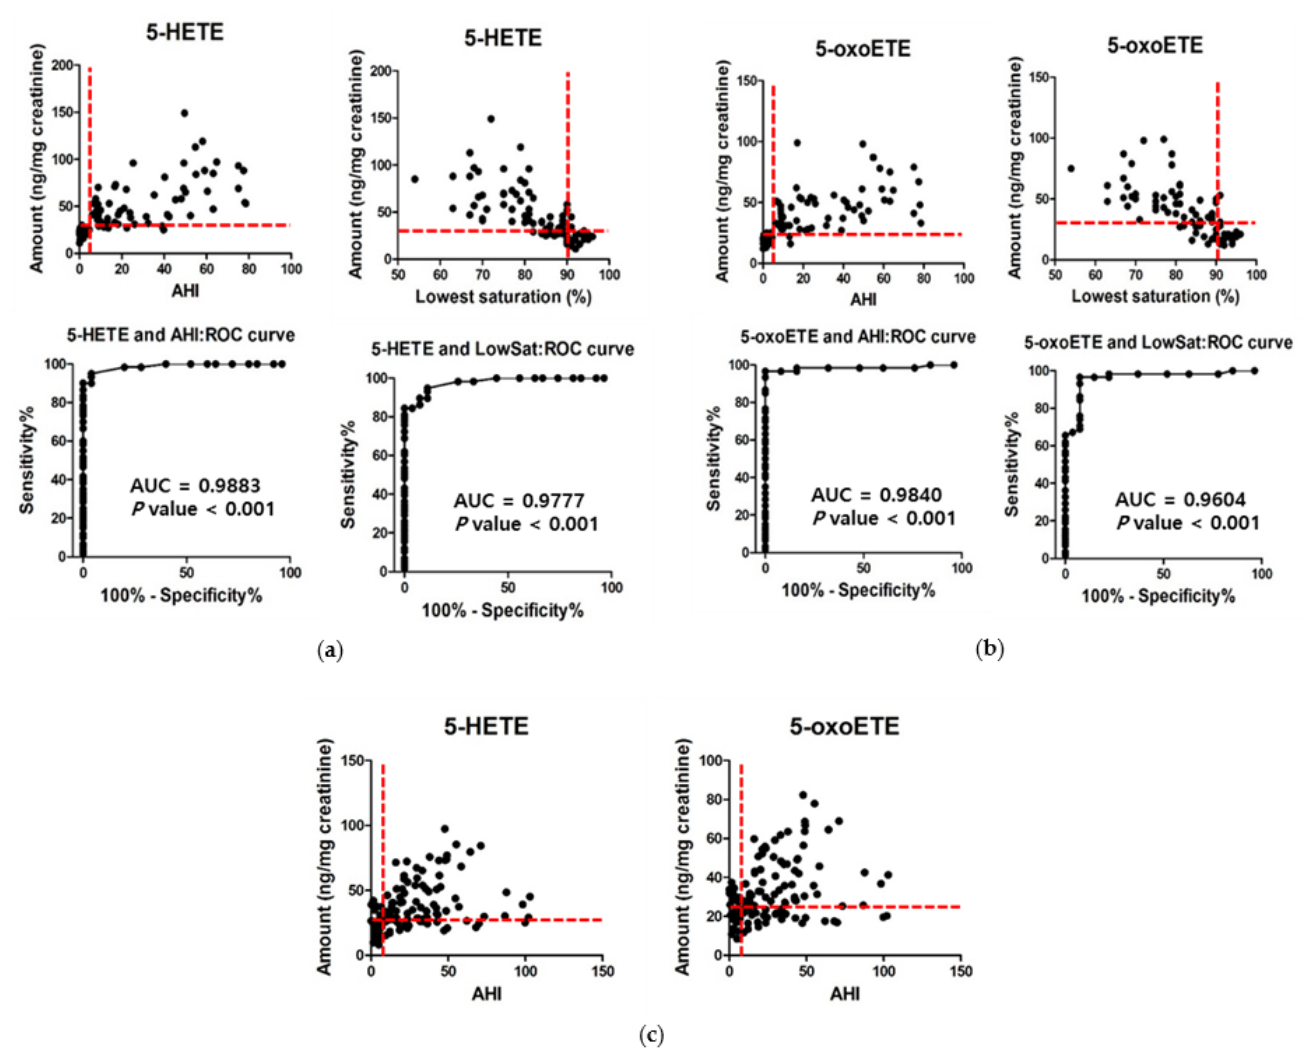
Figure 3. Verification of 5 ‐ HETE or 5 ‐ oxoETE as OSA markers. ( a , b ) Amount of 5 ‐ HETE or 5 ‐ oxoETE in urine from a verification cohort and their correlations with AHI or the lowest saturation on polysomnography. Receiver ‐ operating ‐ characteristic (ROC) analysis was performed to quantify the diagnostic values of each candidate biomarker. AUC, the area under curve. ( c ) Amount of 5 ‐ HETE or 5 ‐ oxoETE in urine from a validation cohort and their correlations with AHI or the lowest saturation on polysomnography.